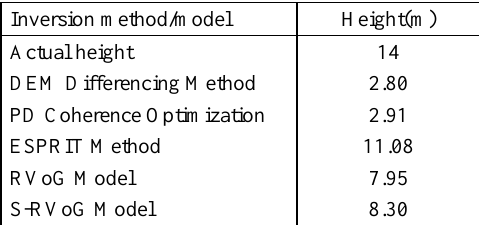
Table 1. Comparison of forest height inversion